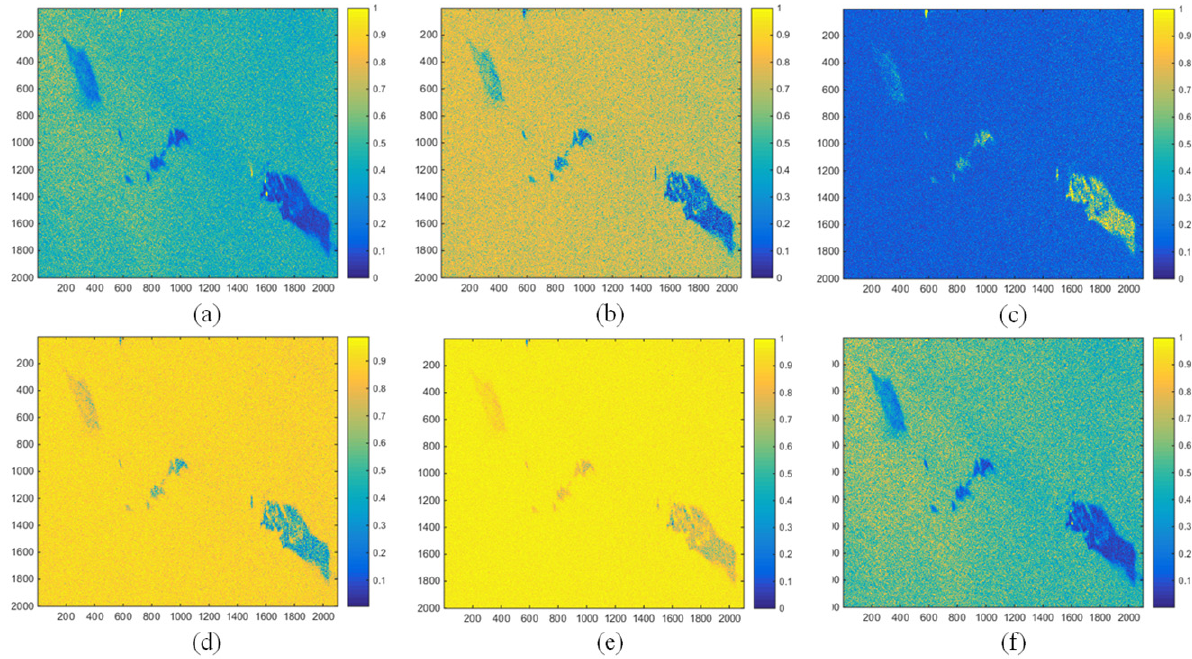
√ g 0 ; ( b ) 1 − H w ; ; ( b ) 1 − 𝐻 ; ( c ) (cid:3050) 0